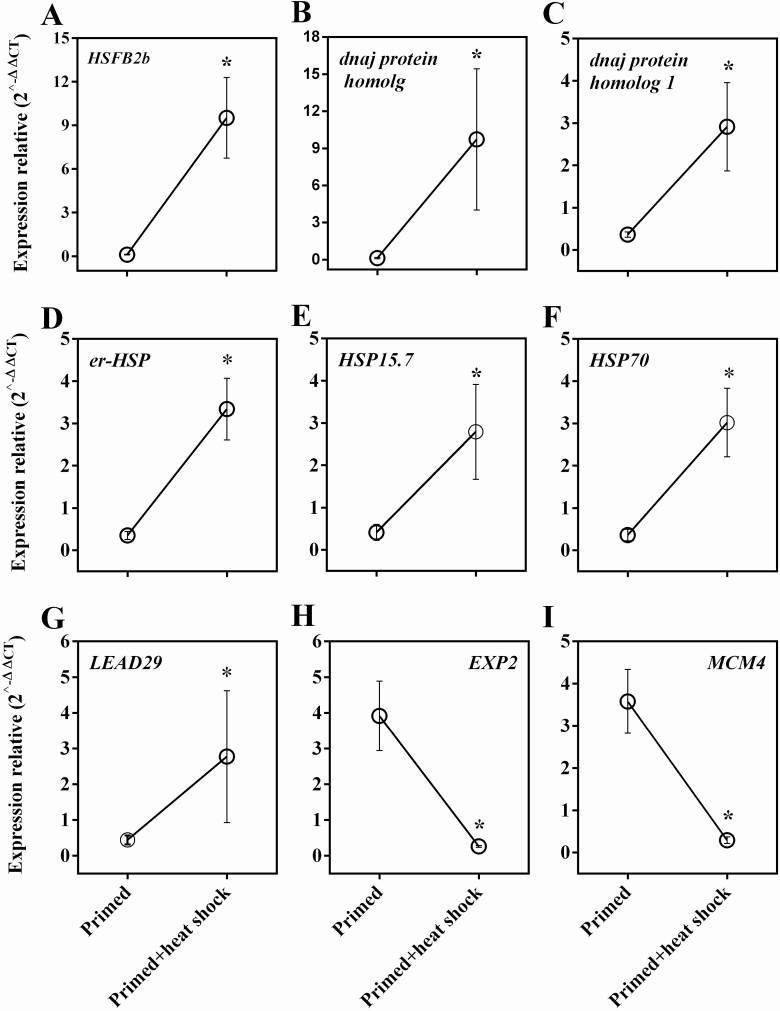
RT-qPCR of selected genes from primed and primed+heat shock treatment (38 °C/32 % RH) validated the RNAseq data. *Significant difference of expression between primed+heat shock and primed samples using the Pair-Wise Fixed Reallocation Randomization Test (n = 3). Error bars show standard deviation.